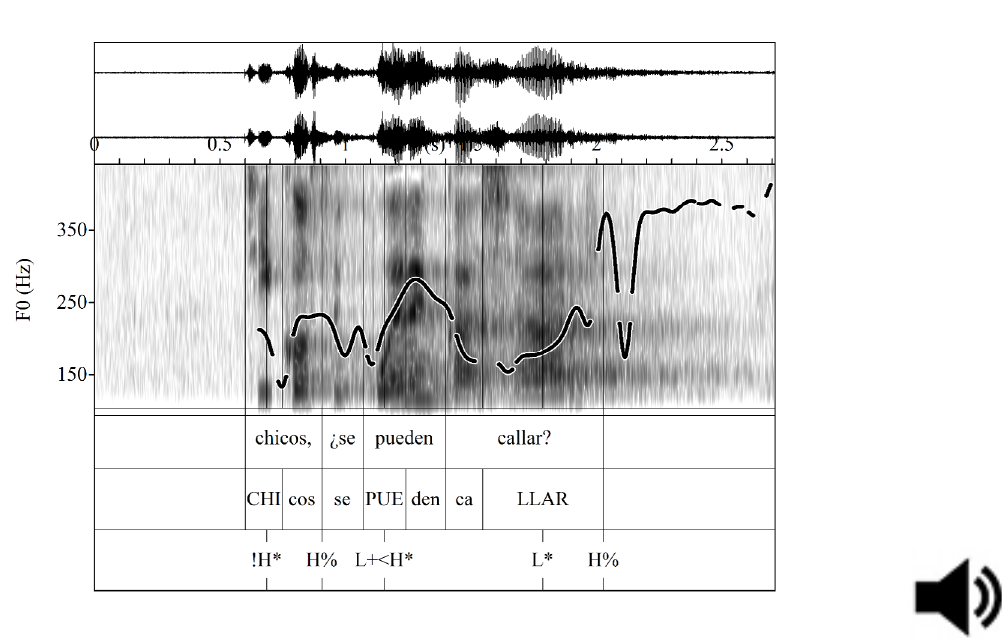
Figure 17 (Participant 2) : Waveform and F0 trace for the imperative yes-no question ¿ Chicos, se pueden callar? ‘Kids, can you please be quiet?’ produced with two IPs. The imperative itself is realized as L+<H* (pre-nuclear accent) and as L* H% (nuclear